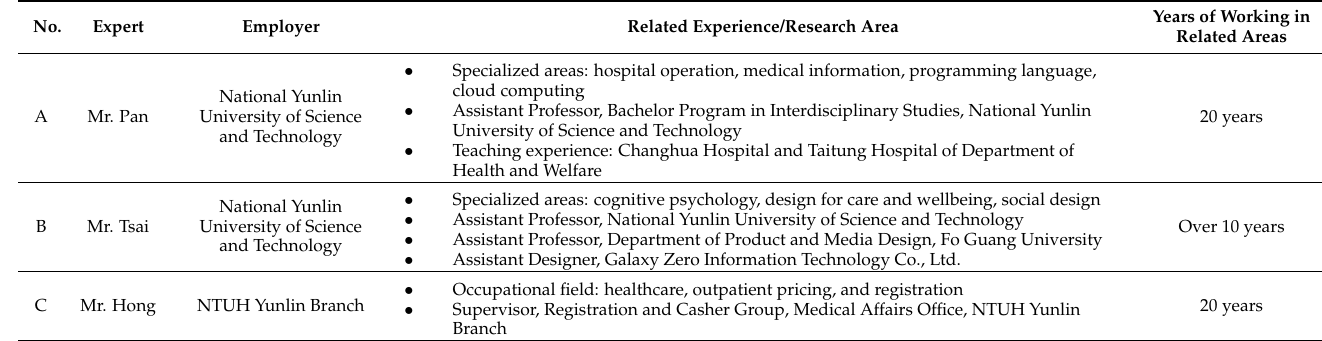
Table 4. Backgrounds of expert subjects.